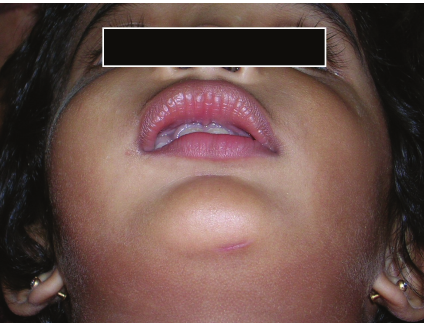
Figure 1: Extraoral view showing mild swelling on the right and left mid face.